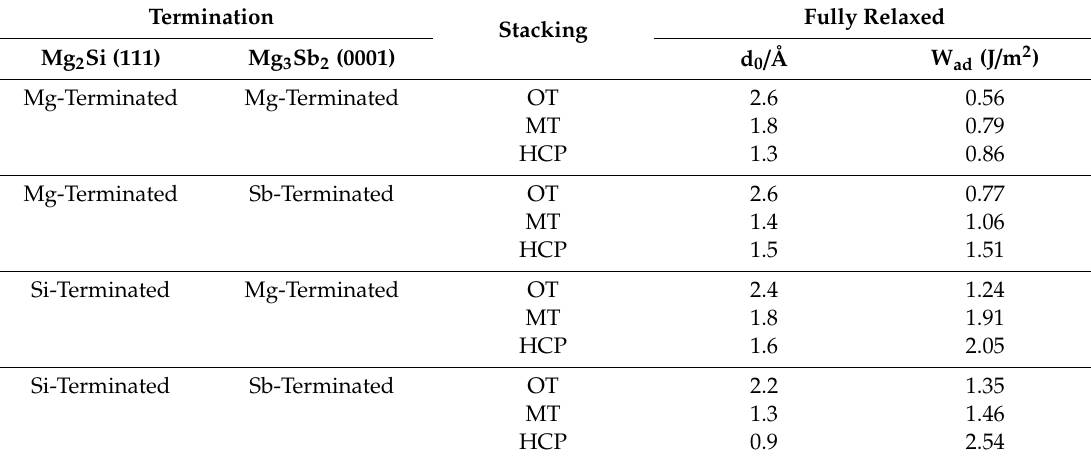
Table 3. The Interfacial distance (d 0 ) and interfacial energy (y int ) after full